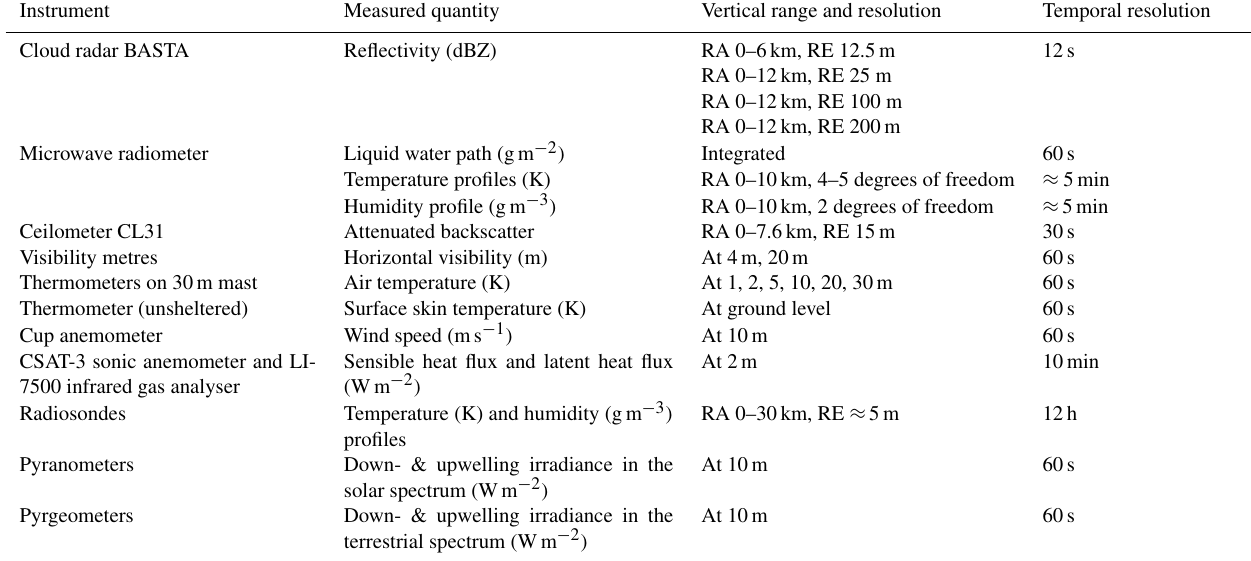
Table 1. Vertical and temporal resolution of the observations used in this study. All instruments are located at the SIRTA observatory main facility, apart from the radiosondes which are launched at Trappes (15km west of the site) at approximately 11:15 and 23:15UTC. The measurements by the cloud radar, ceilometer and microwave radiometer are obtained from remote sensing, while the other instruments measure in